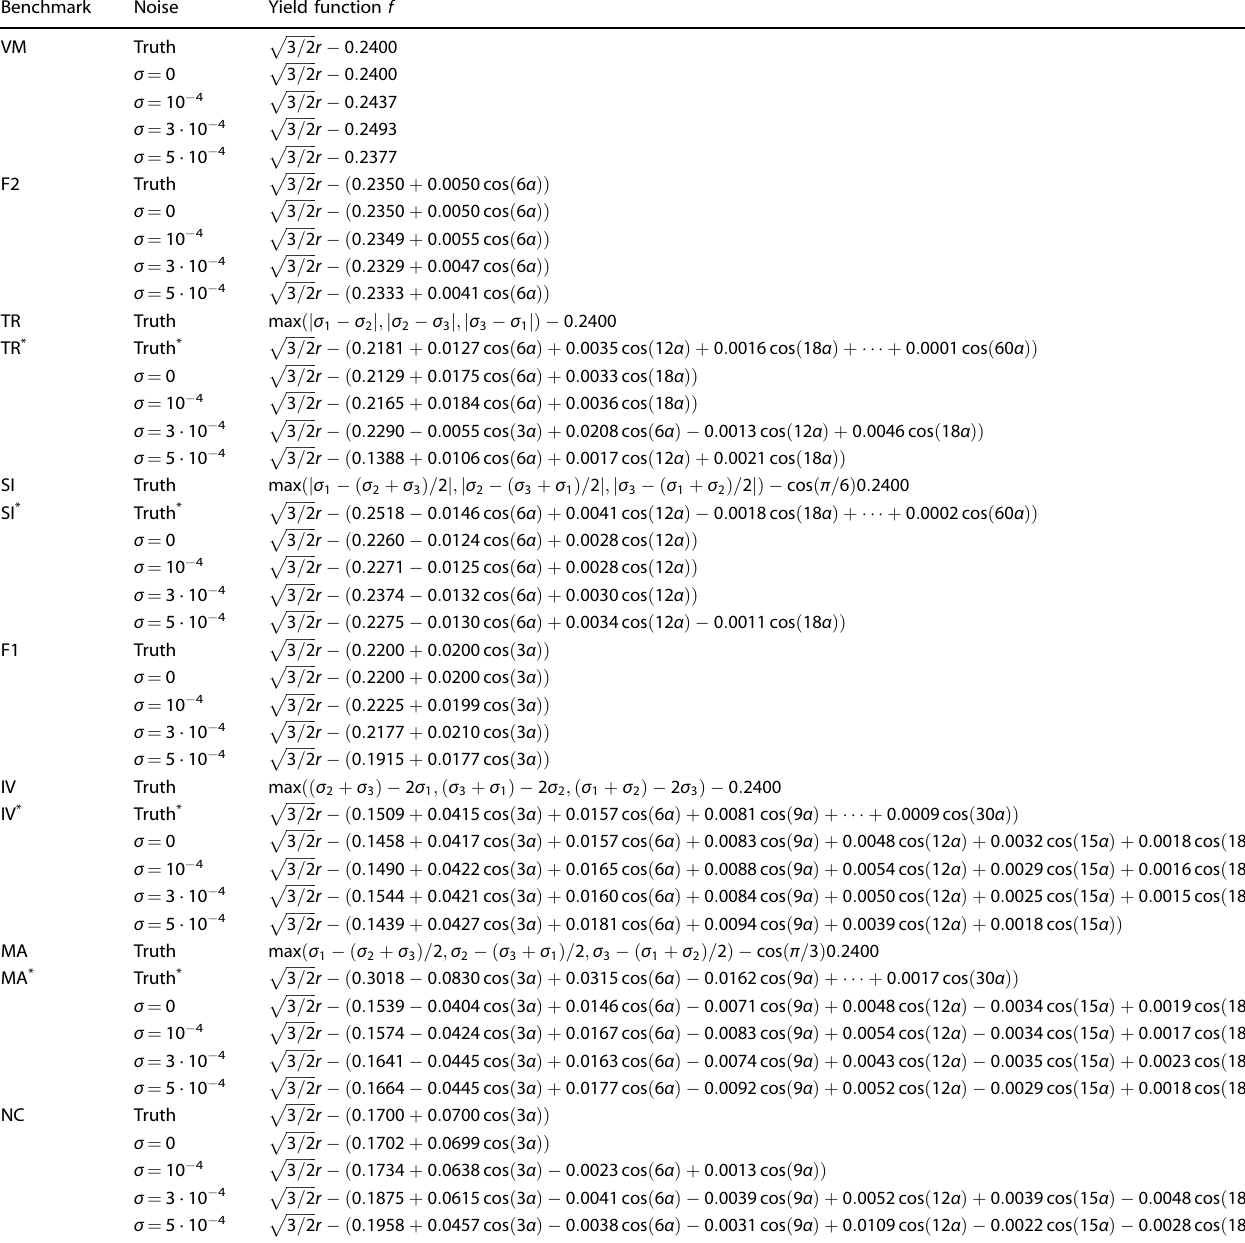
Table 1. Yield functions of the (true) hidden and discovered material models ( γ = 0, σ in mm, parameters in kN mm − 2 ).